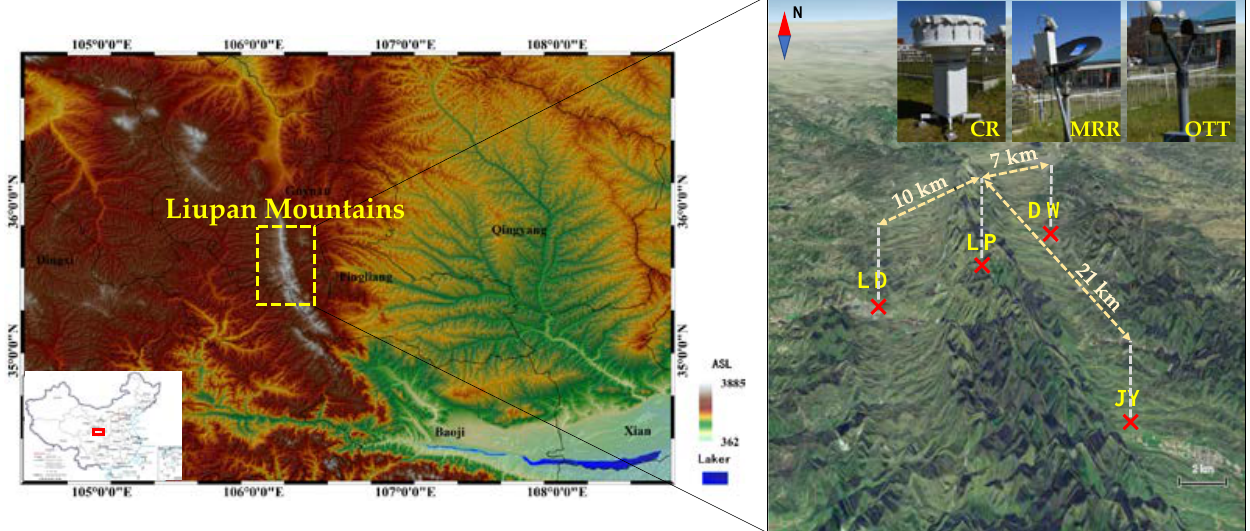
Figure 1. Geographical location and terrain of the Liupan Mountains, and the distribution of four observation sites, namely, the Longde (LD, 2079 m ASL, windward slope), Liupan (LP, 2842 m ASL, mountaintop), Dawan (DW, 1981 m ASL, leeward slope), and Jingyuan sites (JY, 1985 m ASL, leeward slope) and instrument scenes. The CR, MRR, and OTT denote Ka-band millimeter-wave cloud radar, K-band micro rain radar, and laser-based ground disdrometer, respectively.